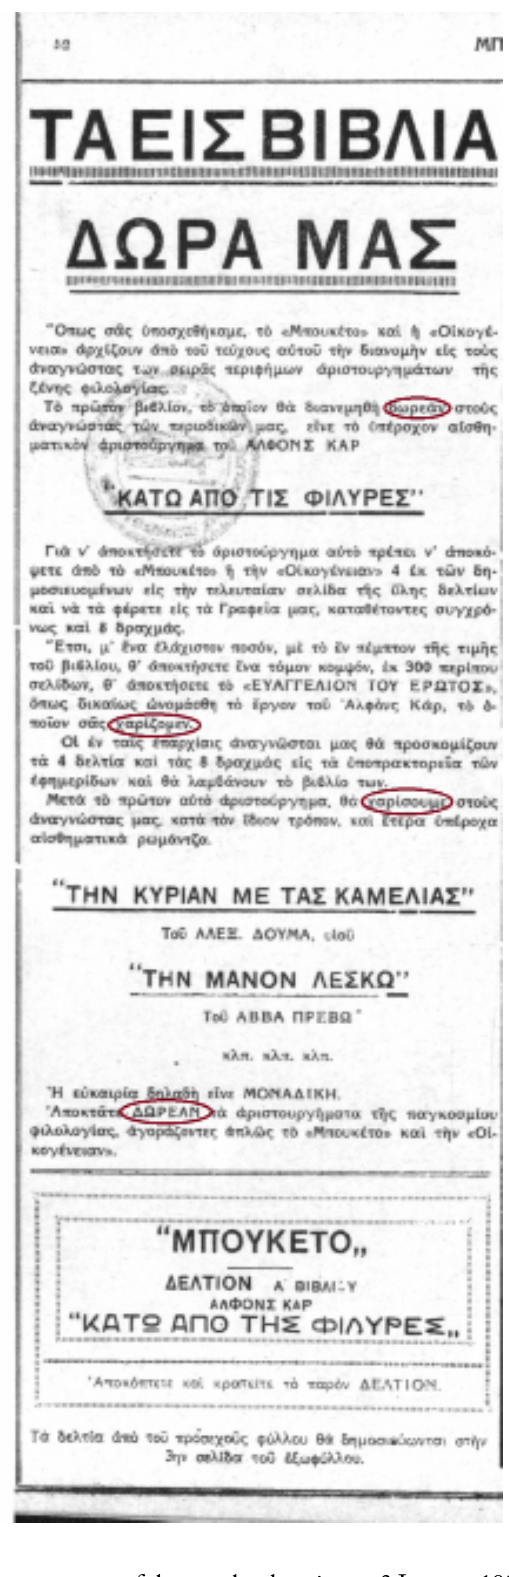
Fig. 2 First announcement of the new book series on 3 January 1935. The title ‘Our gifts in the form of books’ and several other expressions ‘free’. The coupon is at the bottom of the page. Library of the Hellenic Parliament Digitized